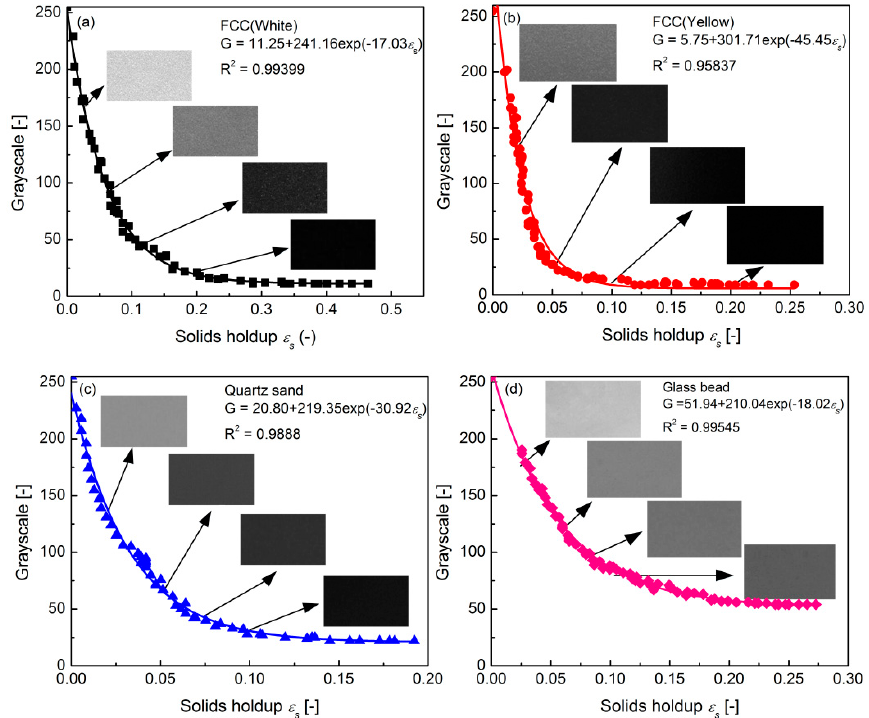
Figure 8. Calibration curve of Geldart A/A-B particles. ( a ) Whtie FCC catalyst particle. ( b ) Yellow